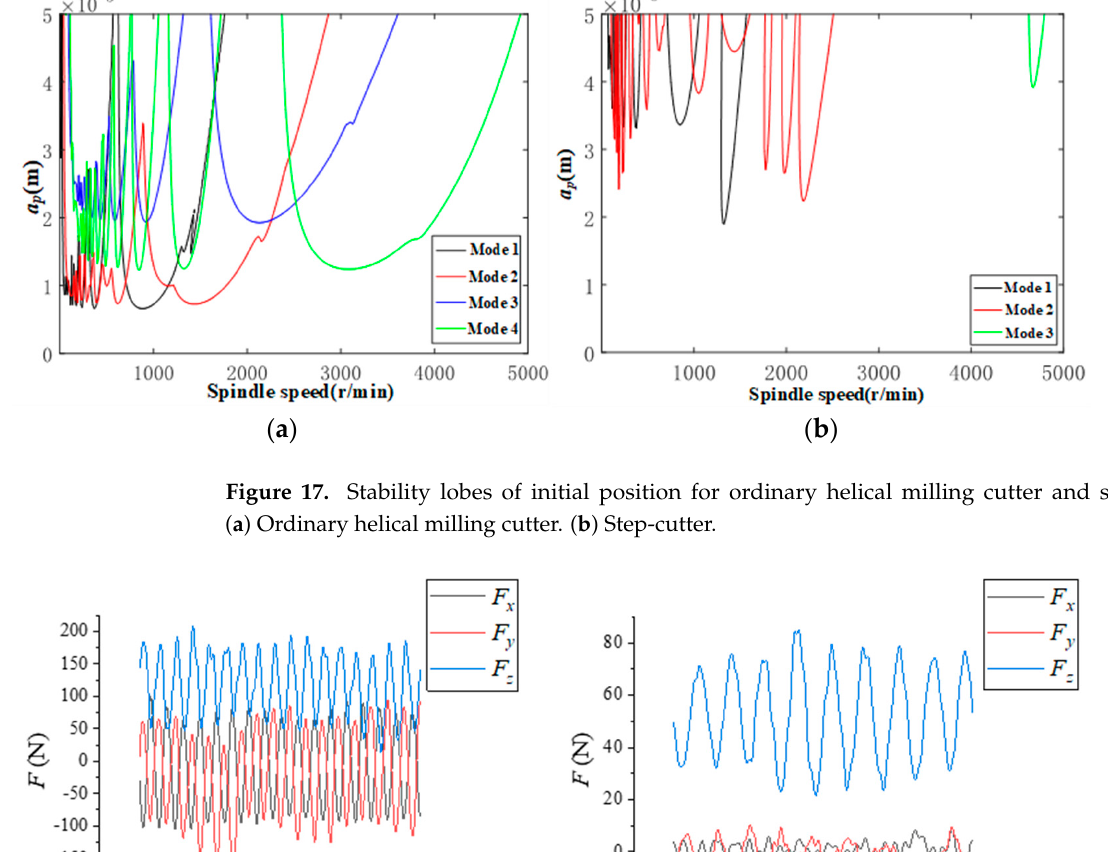
( d ) Figure 16. Stable lobe of TriMule with different radial cutting depths at Position 1. ( a ) d = 0.8. ( b ) d = 0.6. ( c ) d = 0.4. ( d ) d = 0.2.